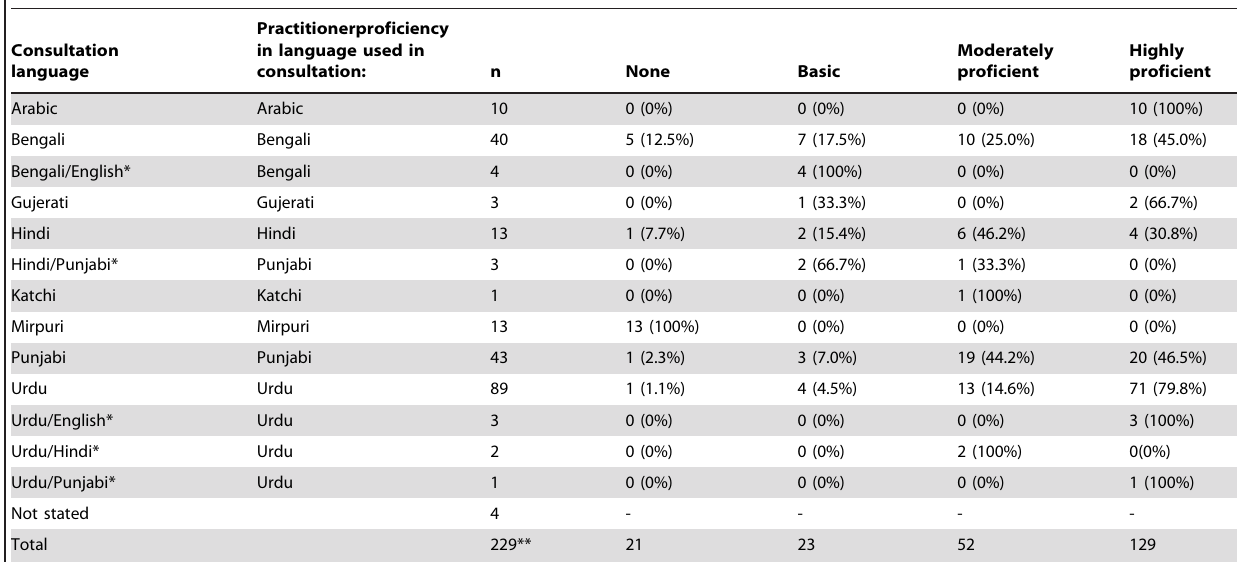
Table 5. Language used in consultation (where other than English).